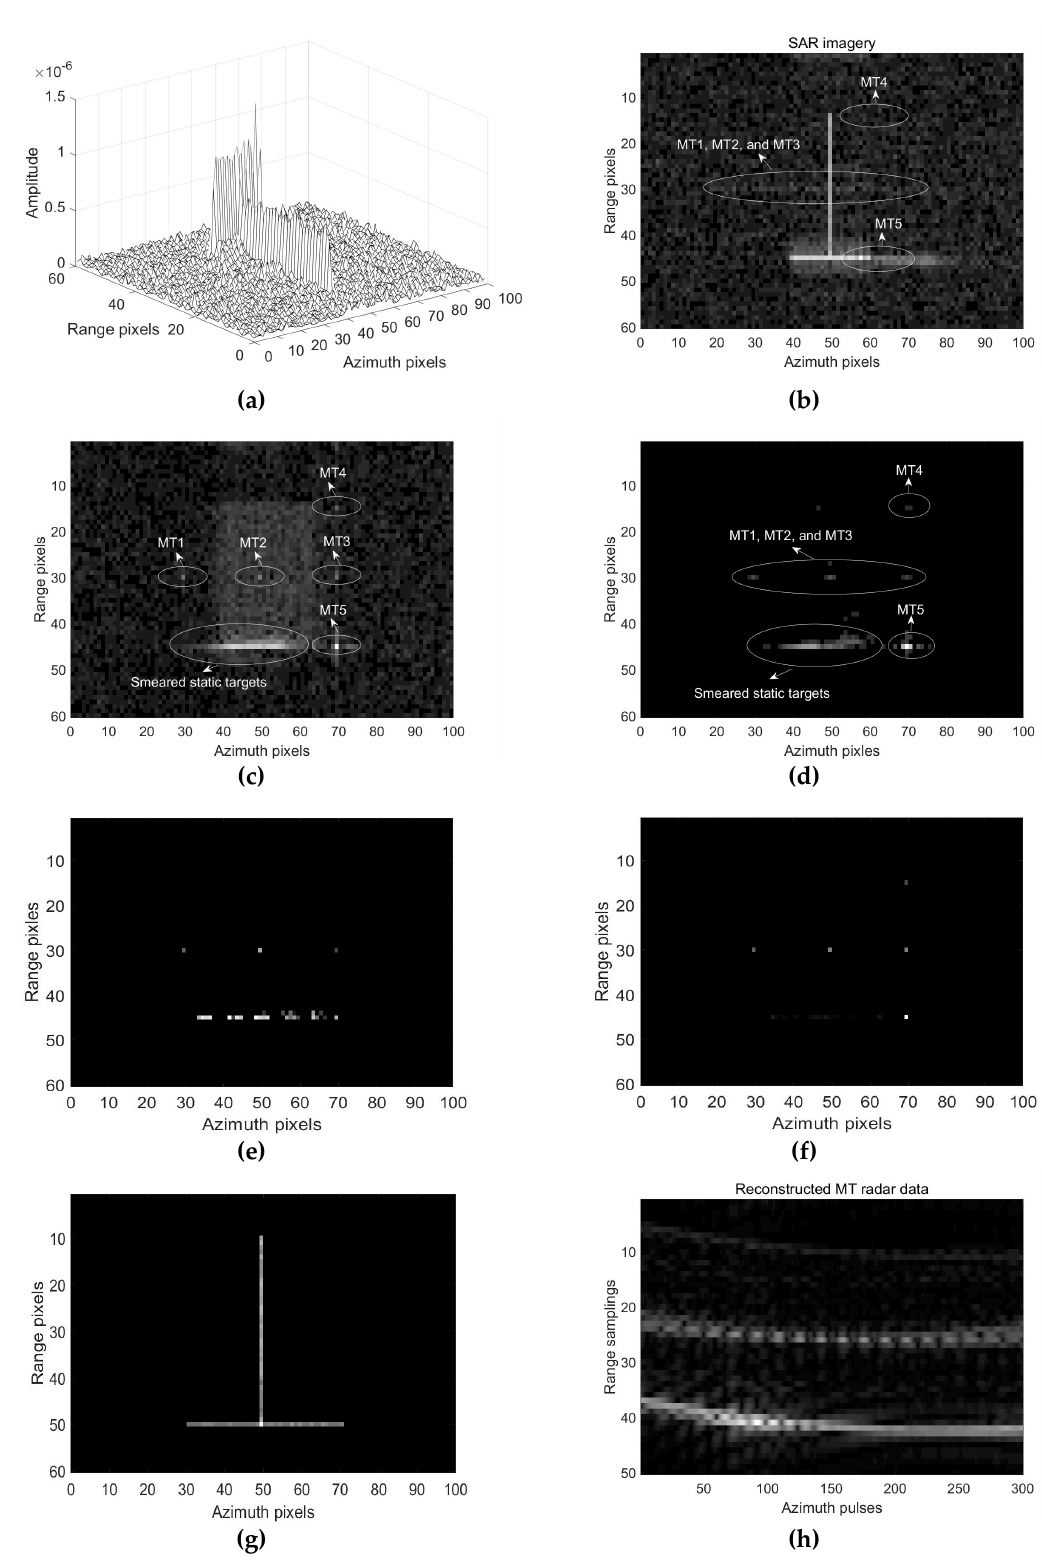
Figure 4. MF and sparse imaging results. ( a ) 3-D figure of SAR imagery; ( b ) 2-D SAR imagery; ( c ) imagery result derived by frequency domain matched filtering; ( d ) imagery result after interferometry; ( e ) imagery derived based on the L1 norm regularization; ( f ) and ( g ) MT imagery and static scene imagery, respectively, after the joint sparse processing; and ( h ) reconstructed MT radar data.